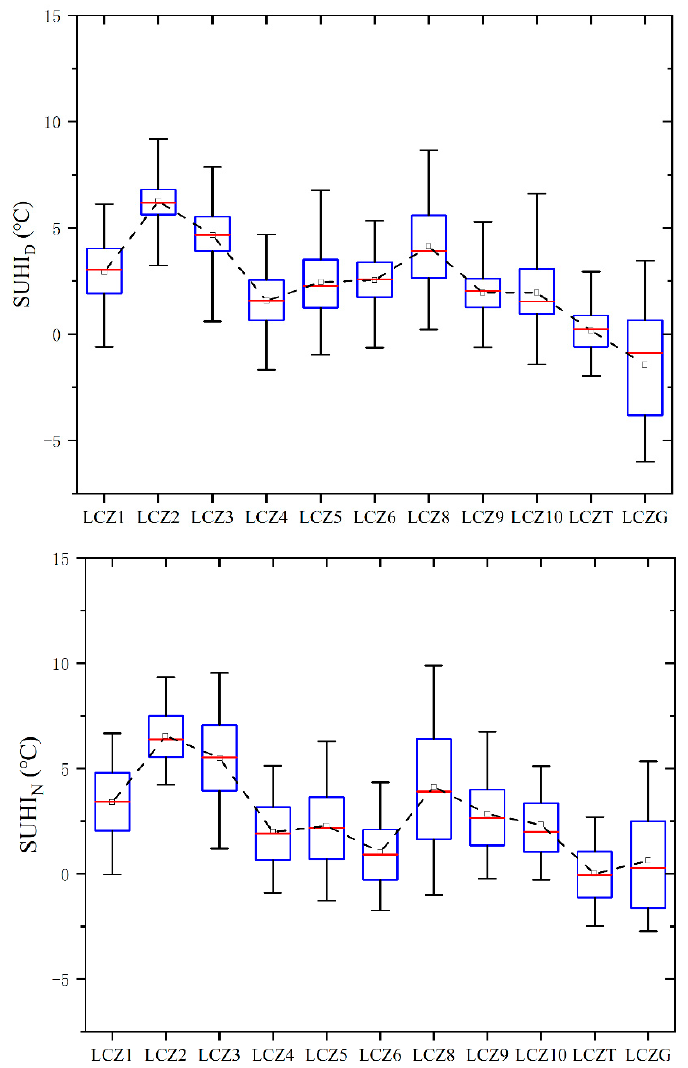
Figure 8. Box plots with SUHIs in LCZs: The line within the box indicates the median. The rectangular indicates the average. The bottom of the box is the first quartile and the top is the third quartile. The connecting line is connected to each average value.